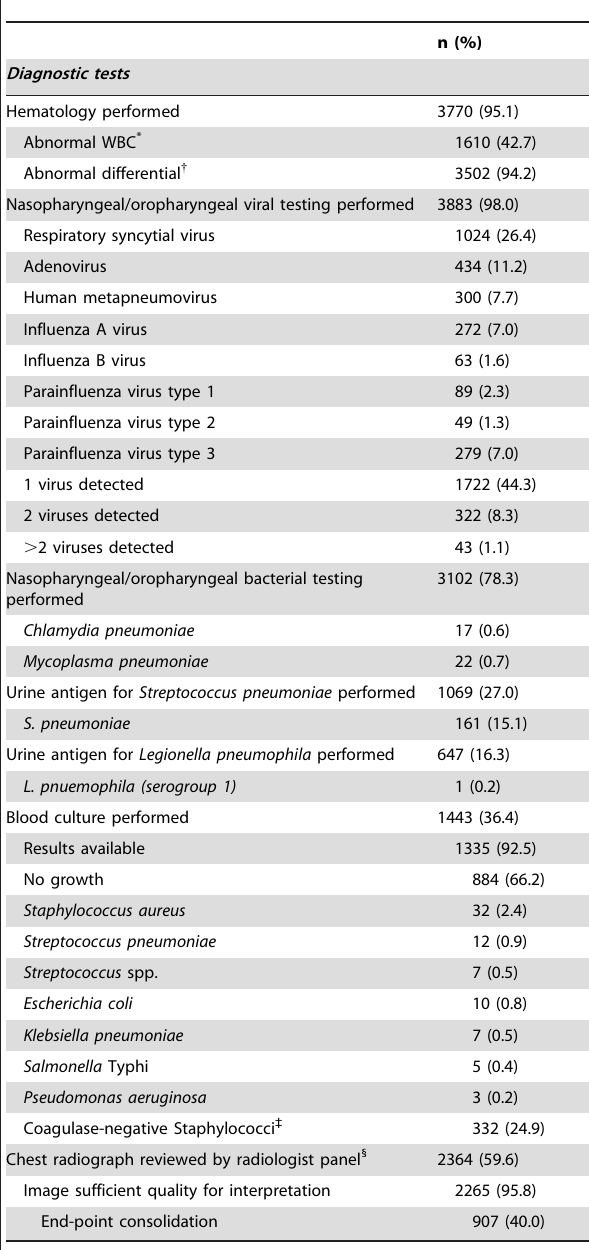
Table 3. Diagnostic tests performed, results, and probable etiologies among hospitalized patients with acute respiratory infections,